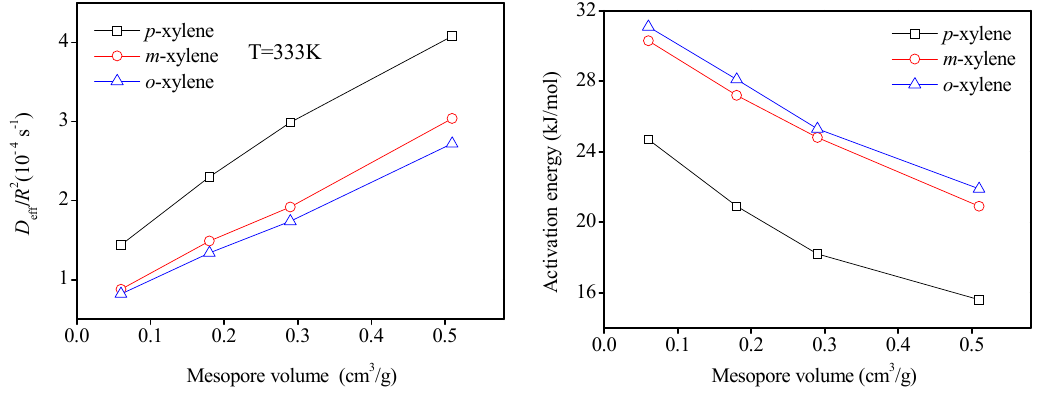
Figure 6. Effective diffusivities at different temperatures and activation energy of xylene isomers as the function of mesopore volume in Beta zeolite